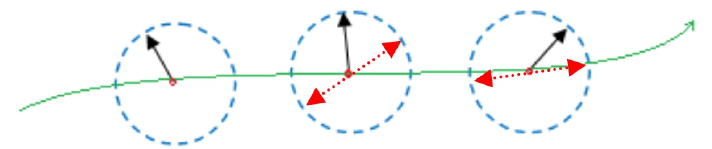
Figure 8. The example of the second constrain conditions.